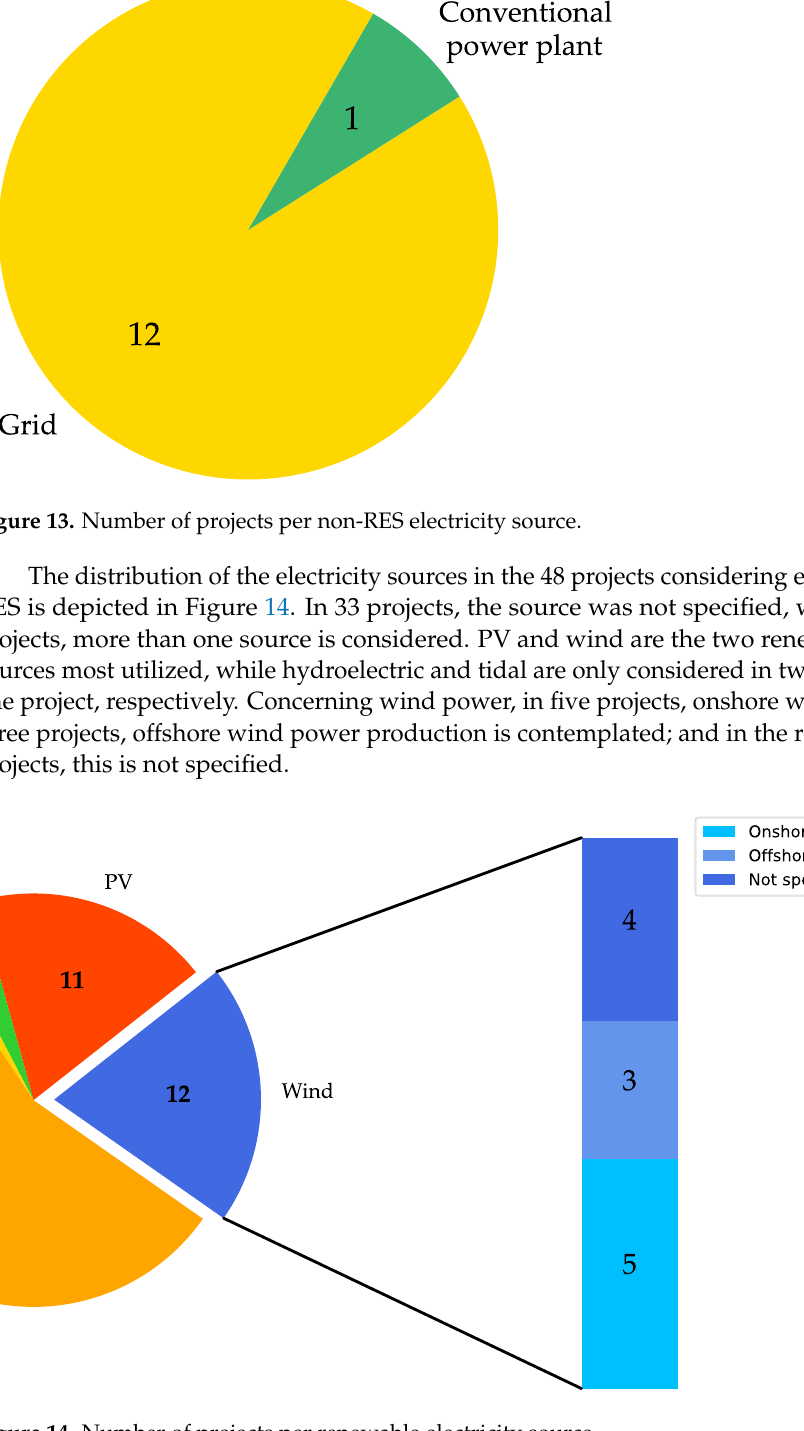
Figure 14. Number of projects per renewable electricity source.